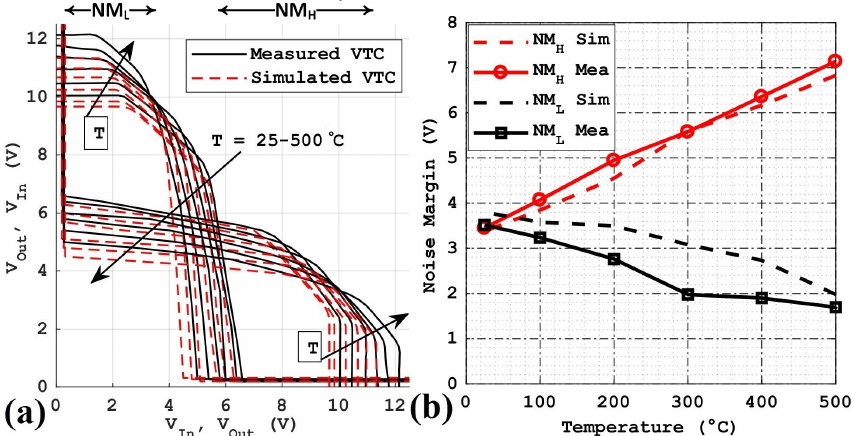
Figure 11. SiC TTL inverter ( a ) simulated vs. measured VTC, ( b ) noise margins as temperature increases from 25 to 500 ○ C at V CC = 15